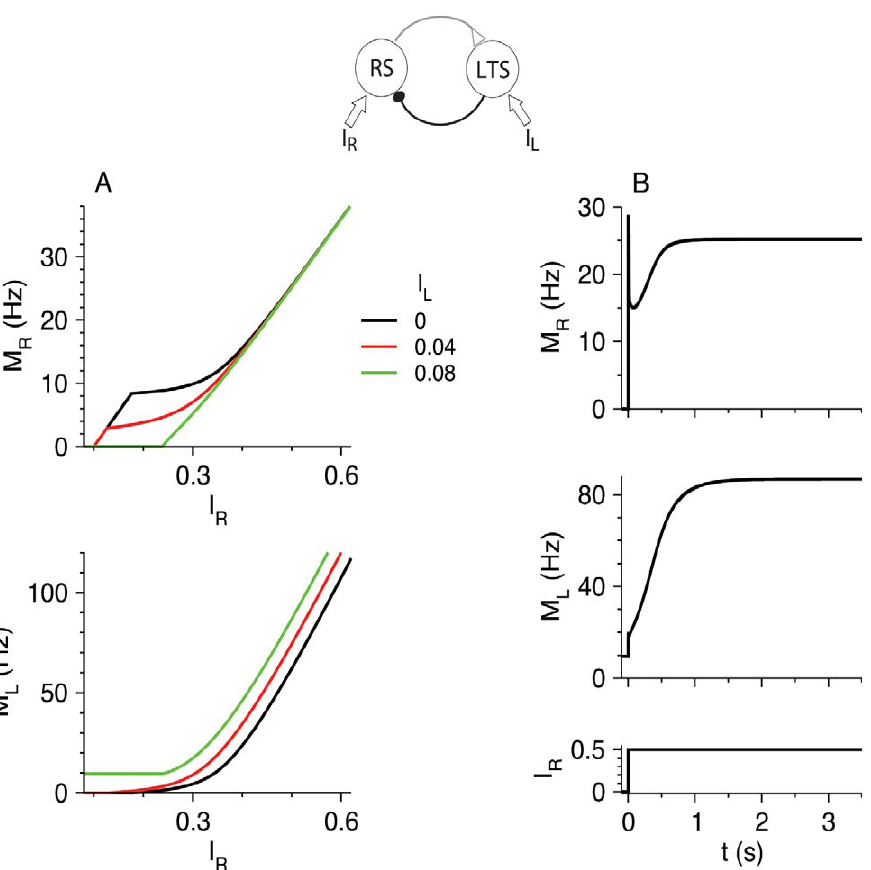
Figure 4. Response of the RS-LTS network with input I L . 0 to LTS neurons. Additional parameters are g RL =35, g LR =7.5, g RR =0. (A) M R - I R curves (top panel) and M L - I R curves (bottom panel), representing the steady-state response of the circuit to the inputs I R and I L to the RS and LTS neurons respectively, are plotted for I L =0 (black), 0.04 (red) and 0.08 (green). (B) Response of the circuit to a step input I R H ( t ) to the RS neurons. Time courses of M R (top panel) and M L (middle panel) are plotted for I R =0.5 (bottom panel). The current I L =0.08 remains constant.